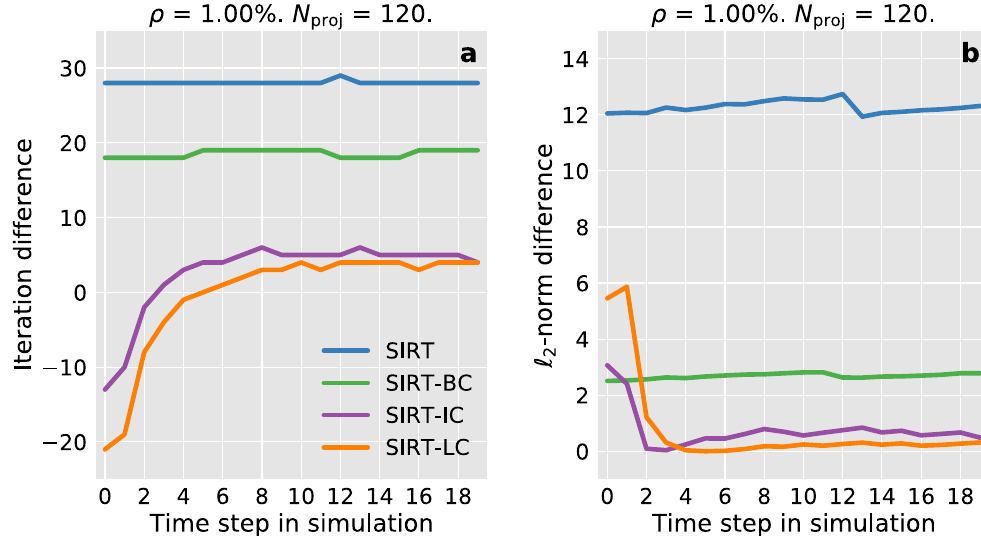
Figure 7. Evaluation of the performance of the NCP stopping criteria. In plot ( a ) the difference between the number of iterations used with the NCP stopping criteria and the ideal number of iterations a function of time step in the simulation. In plot ( b ) the difference between the ℓ 2 -norm of residual when using the NCP stopping criteria and the ideal ℓ 2 -norm is shown as a function of time step in the simulation.